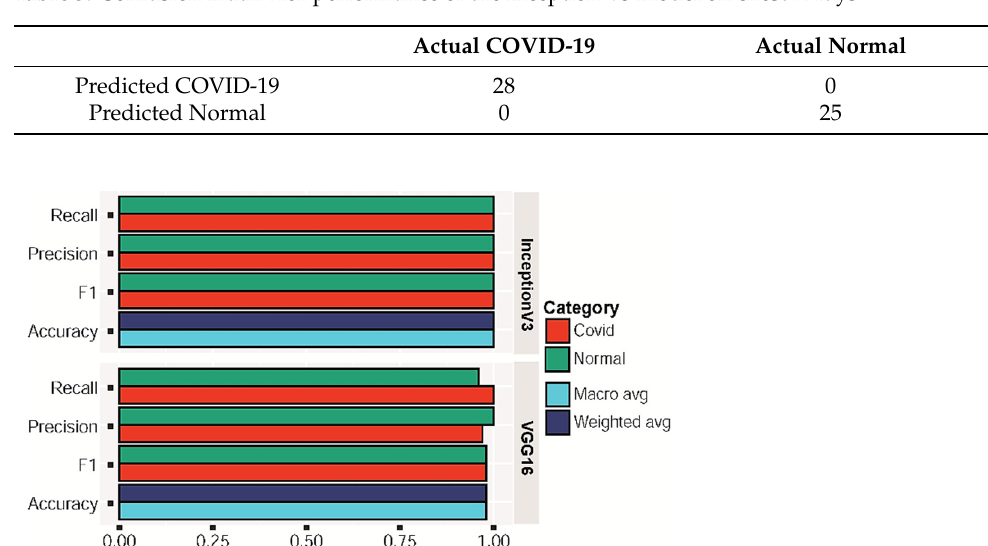
Table 2. Confusion matrix for performance of the VGG16 model on chest X-rays.